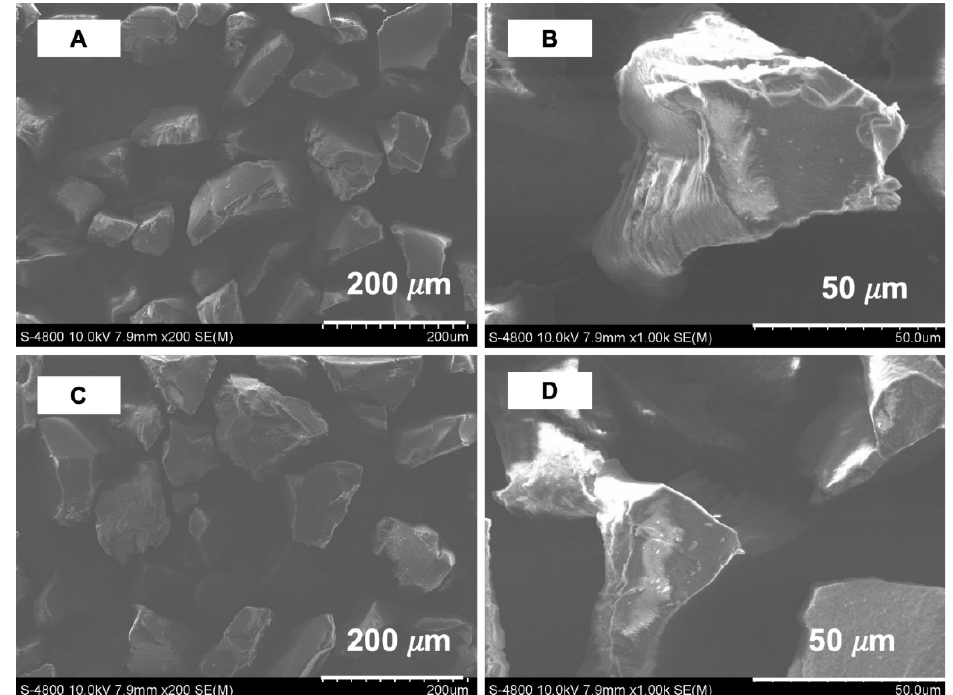
Figure 4. SEM images of MIP7 ( A , B ) and NIP7 ( C , D ) at different magnifications.